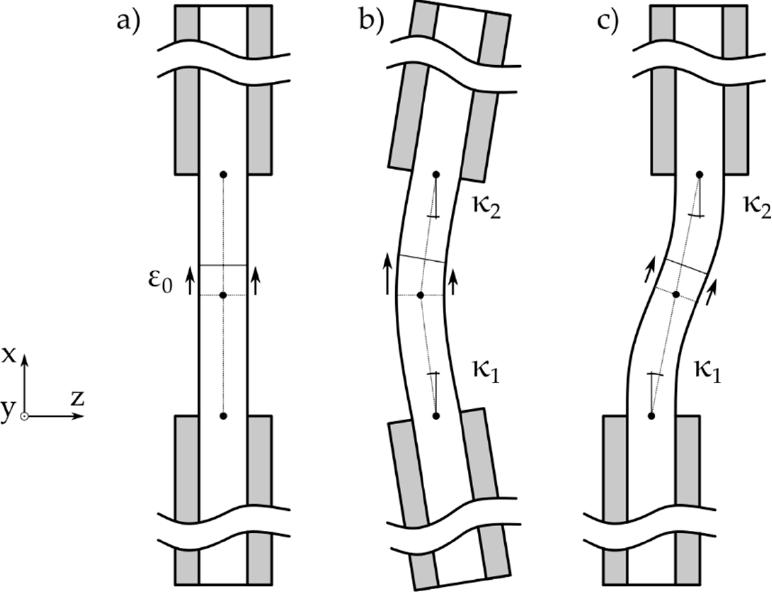
Figure 6. Three possible bending states in a compression specimen: ( a ) ideal load introduction; ( b ) inclined clamps; and ( c ) offset clamps.